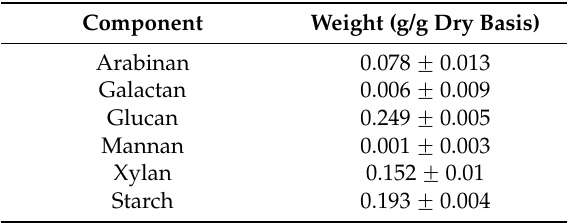
Figure 2. Process flow diagram of the integrated lignocellulose to the thin stillage modified first ethanol production (Scenario C). The modified unit operations from the base case are highlighted. Table 1. Wheat bran composition used for the